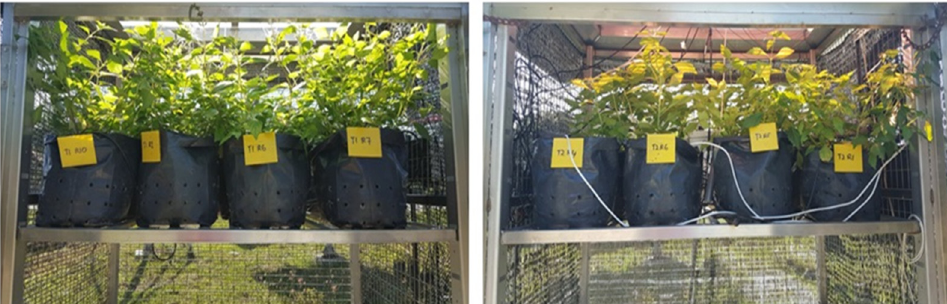
Figure 8. The test crop, Orthosiphon stamineus (Misai Kucing), under control greenhouse with glass as a rooftop ( left picture ) and integrated semi-transparent DSSC as a rooftop (right picture).